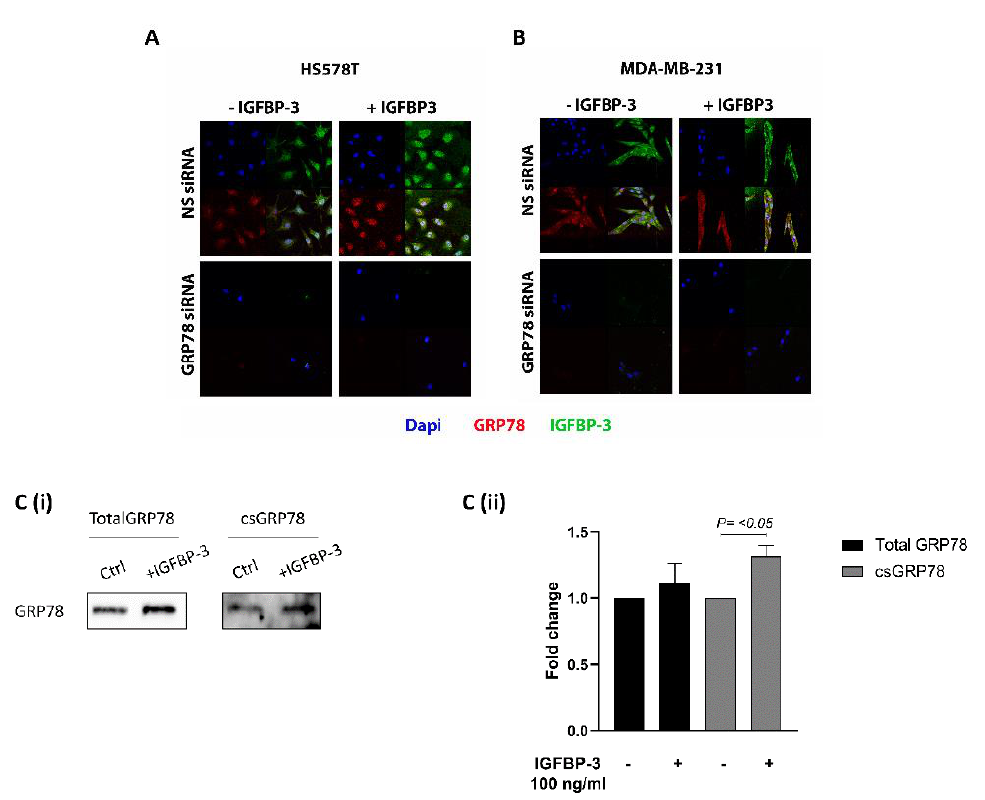
Figure 3. Knock-down of GRP78 blocks the entry of IGFBP-3 into the cells . IF staining of GRP78 and IGFBP-3 in cells treated with IGFBP-3, in the presence or absence of target siRNA to GRP78, or NS siRNA in ( A ) HS578T and ( B ) MDA-MB-231 cells (Original magnification 63×). ( C,i ) Hs578T cells treated with IGFBP-3 with and without GRP78 knocked-down were subjected to cell surface (cs) biotinylation followed by Western blot analysis. ( C,ii ) Quantification of Western blot results shown in ( C,i ). The whole blots (uncropped blots) are shown in the Supplemental